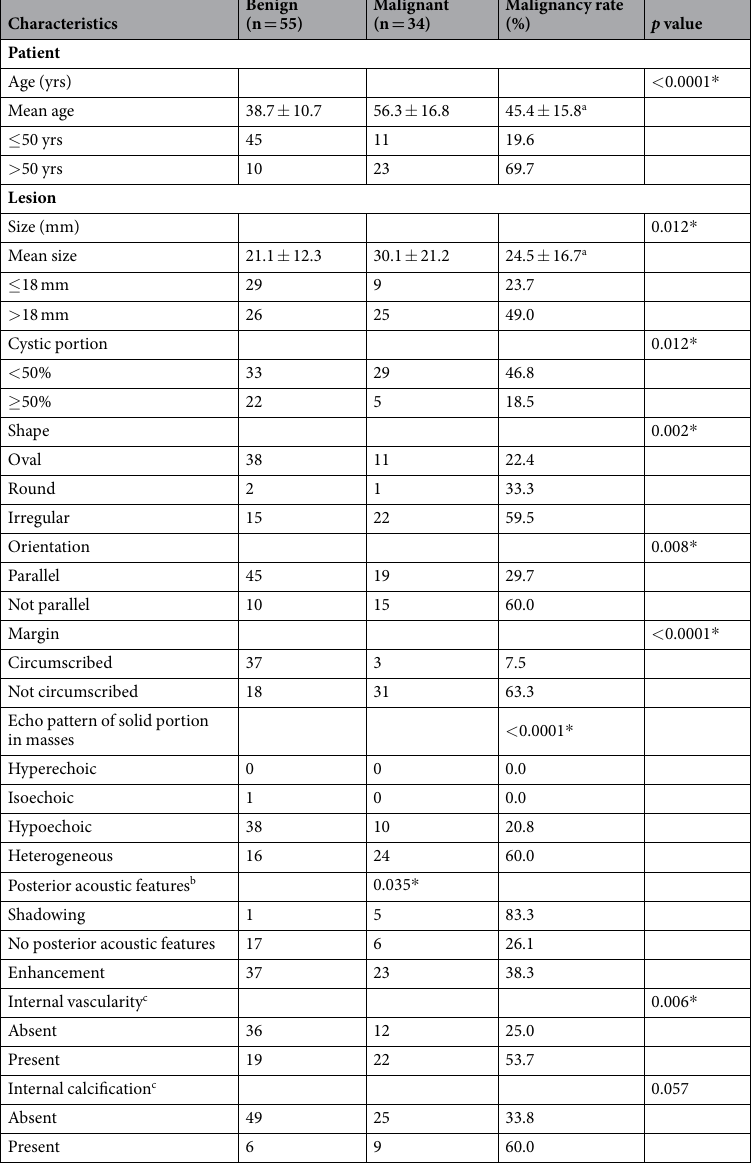
Table 1. Basic characteristics of the patients and ultrasound features of the lesions. * Indicates statistically significant difference at the level of two-tailed 0.05. a Average value which is obtained from the overall lesions. b No lesion was identified to be combined pattern of posterior acoustic features in current study. c Vascularity and calcification out of a lesion were not referred in current study. n